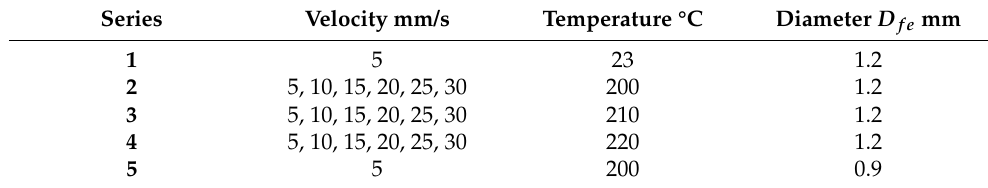
Table 4. Test rig parameters of fibre bundle deformation studies.